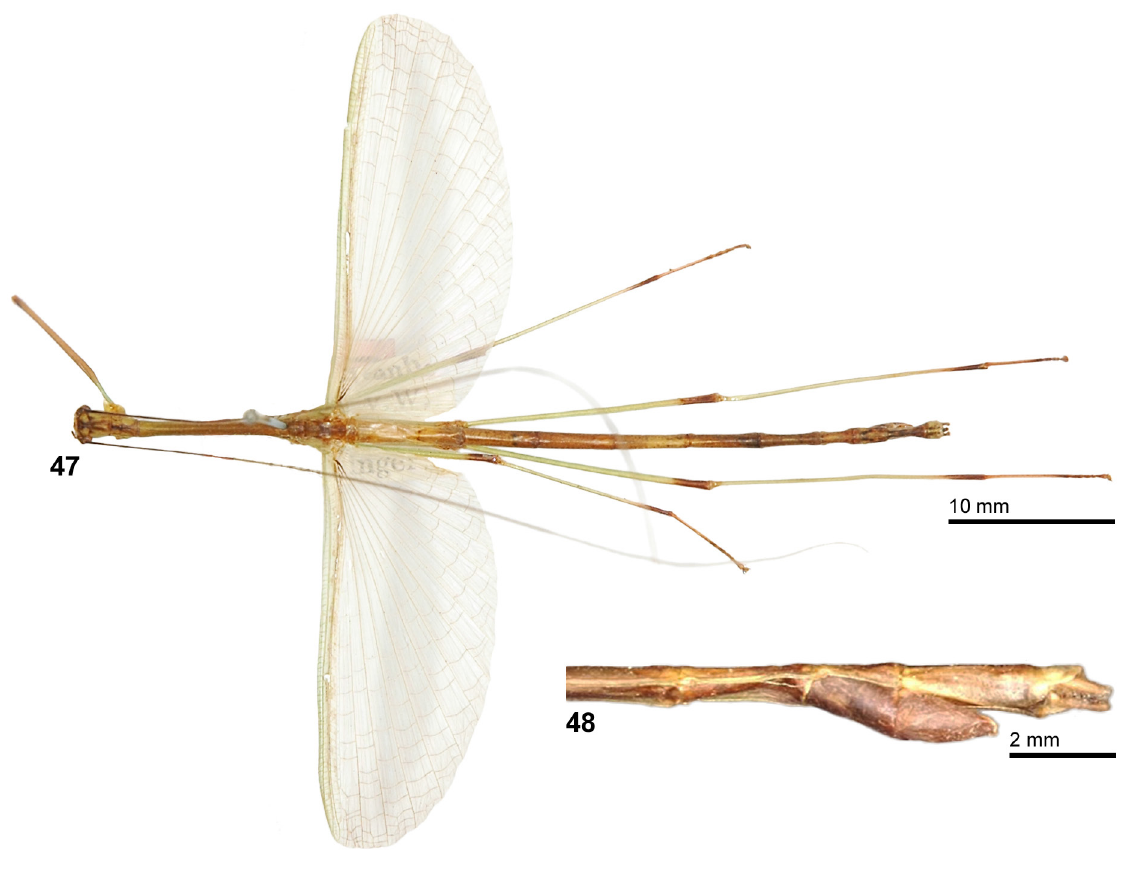
of abdomen, ventrolateral